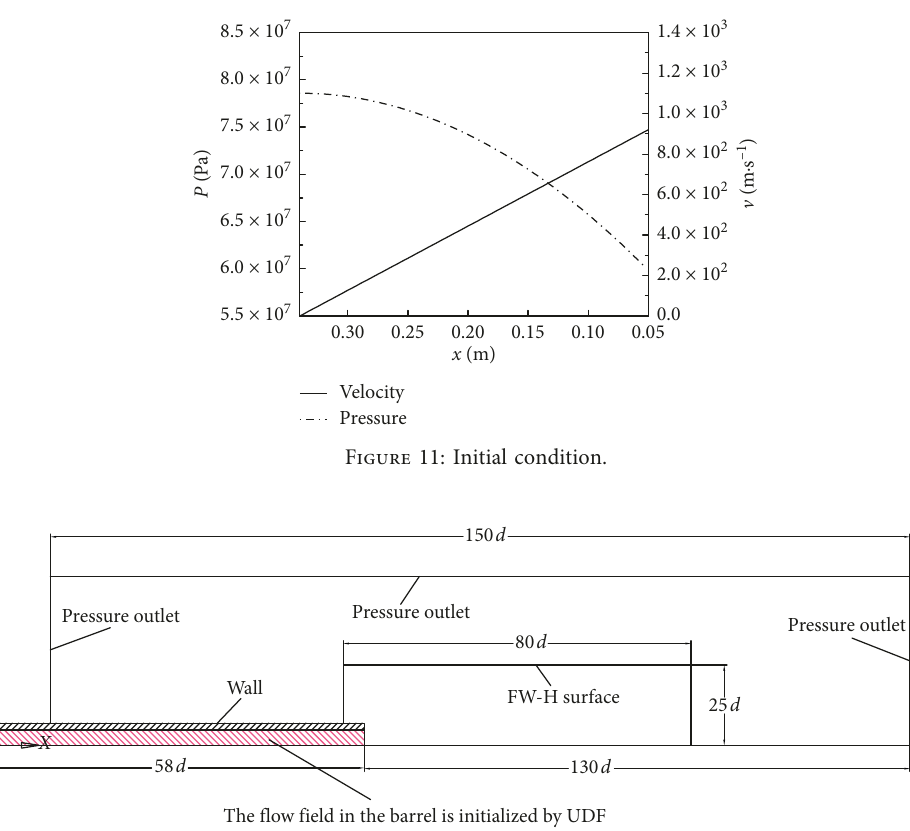
Figure 12: Schematic diagram of the computational domain and boundary